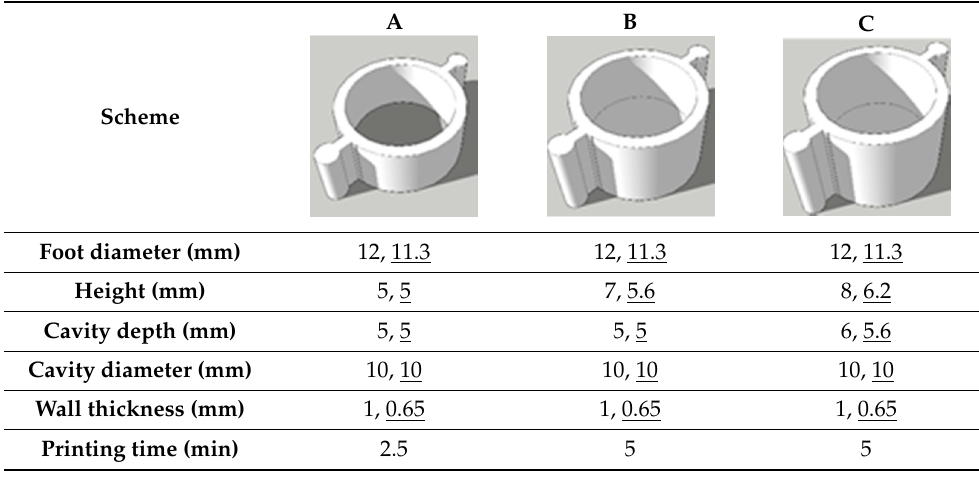
Table 1. Geometry of virtual PLA and PVOH-based scaffold containers used to print physical scaffold containers. Measurements for PVOH – based scaffolds have been underlined. A, B, C refer to different exposed surface area scaffolds with equal internal volume.